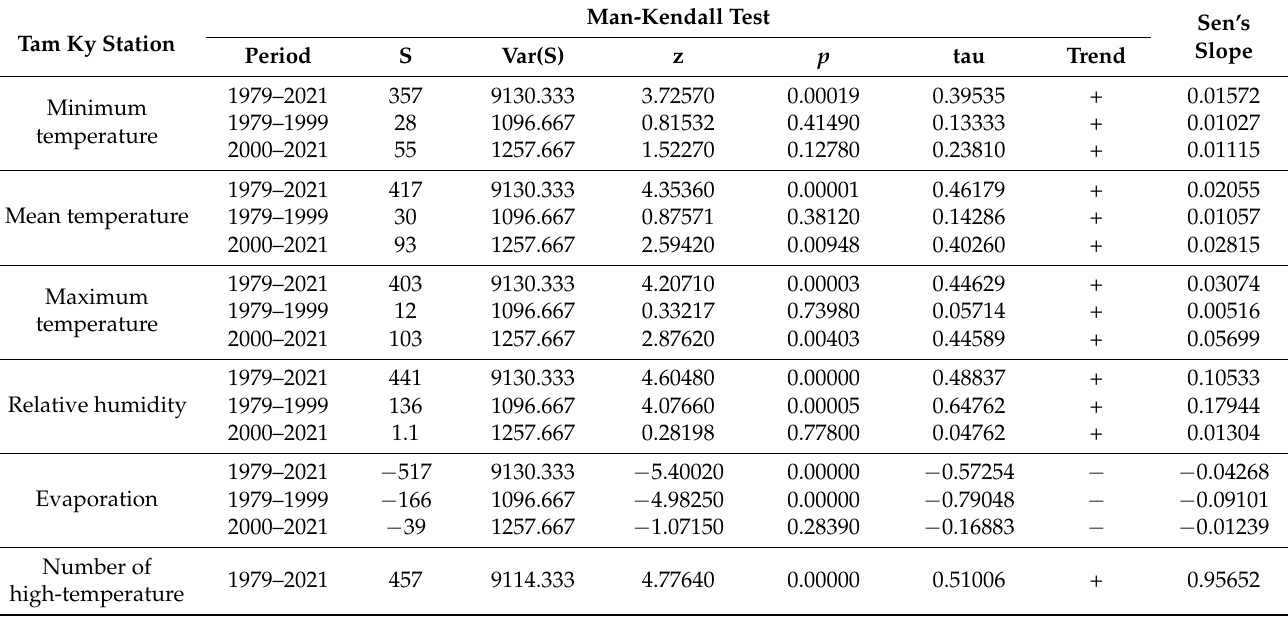
Table 4. Mann–Kendall test trend and Sen’s estimator results at the Tam Ky meteorological station for Quang Nam province.